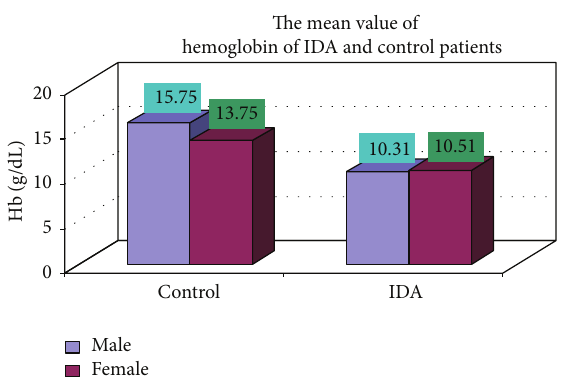
Figure 4: Showing the mean value of hemoglobin of control and iron deficiency